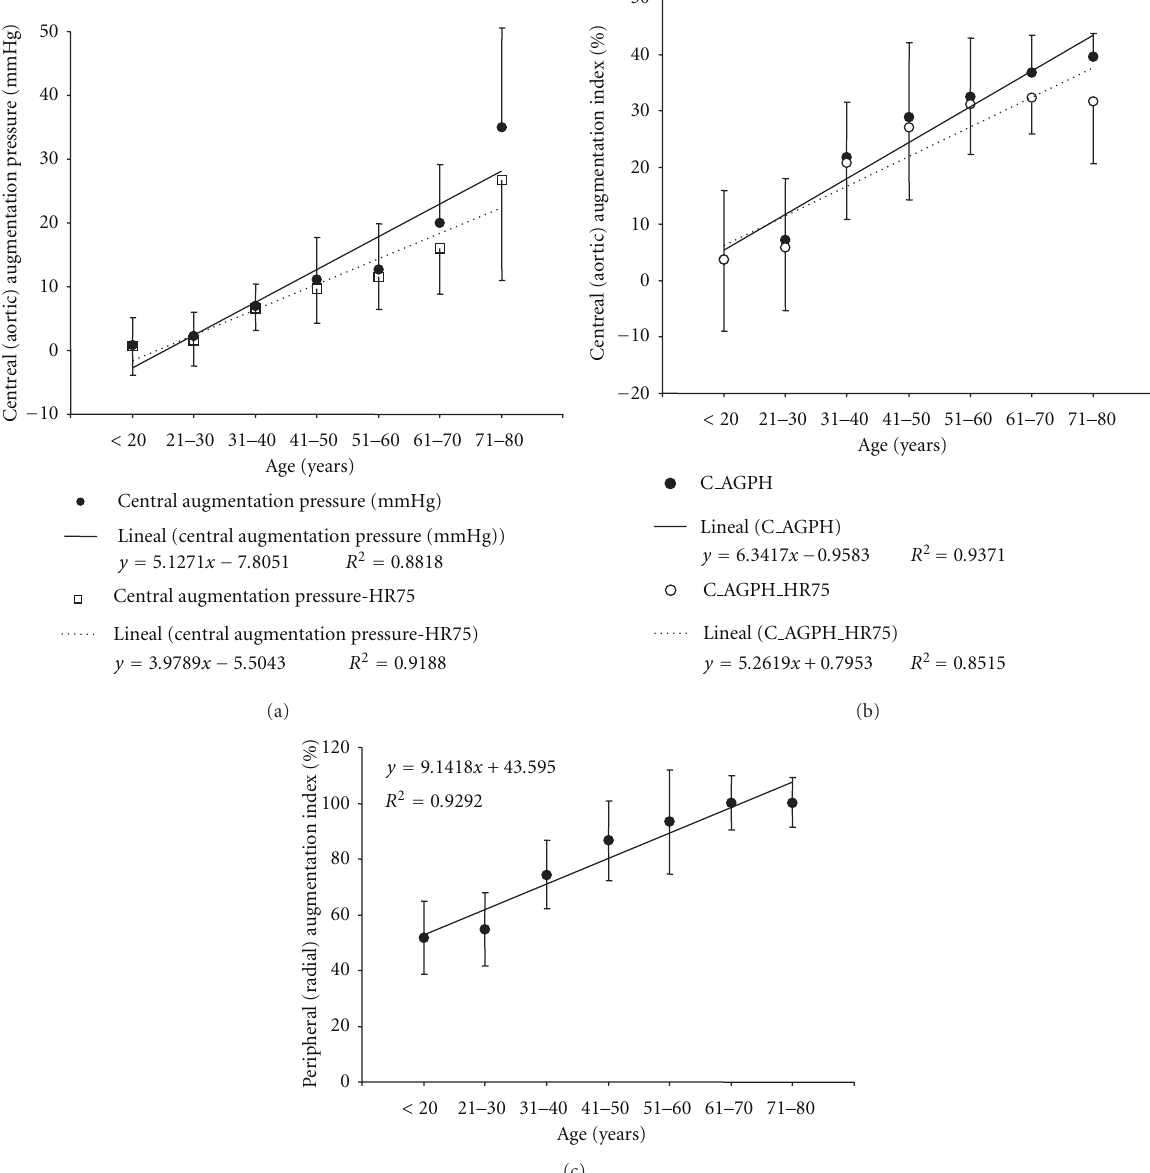
Figure 3: Peripheral (a) and central (b and c) wave reflections indexes age- (decade-) related